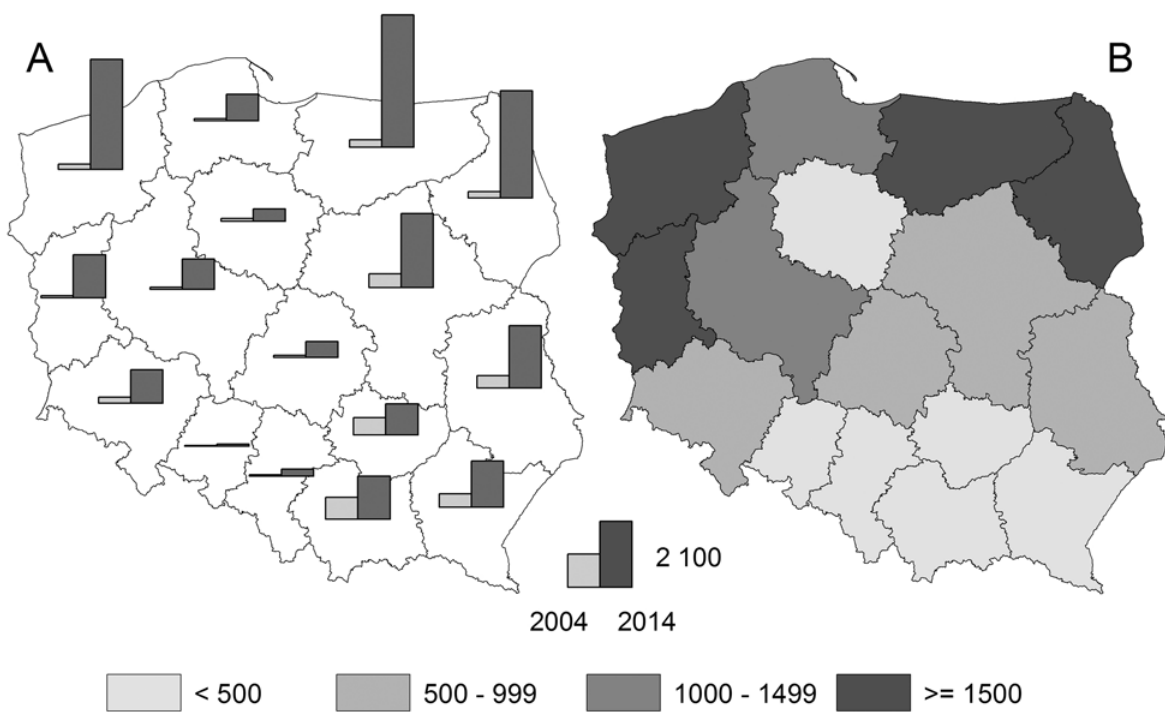
Fig. 5. Number of (A) and changes in (B) organic farms in Poland by voivodeship, 2004 and 2014 (2004 = 100). Source: own calculations based on data from the Agricultural Census.